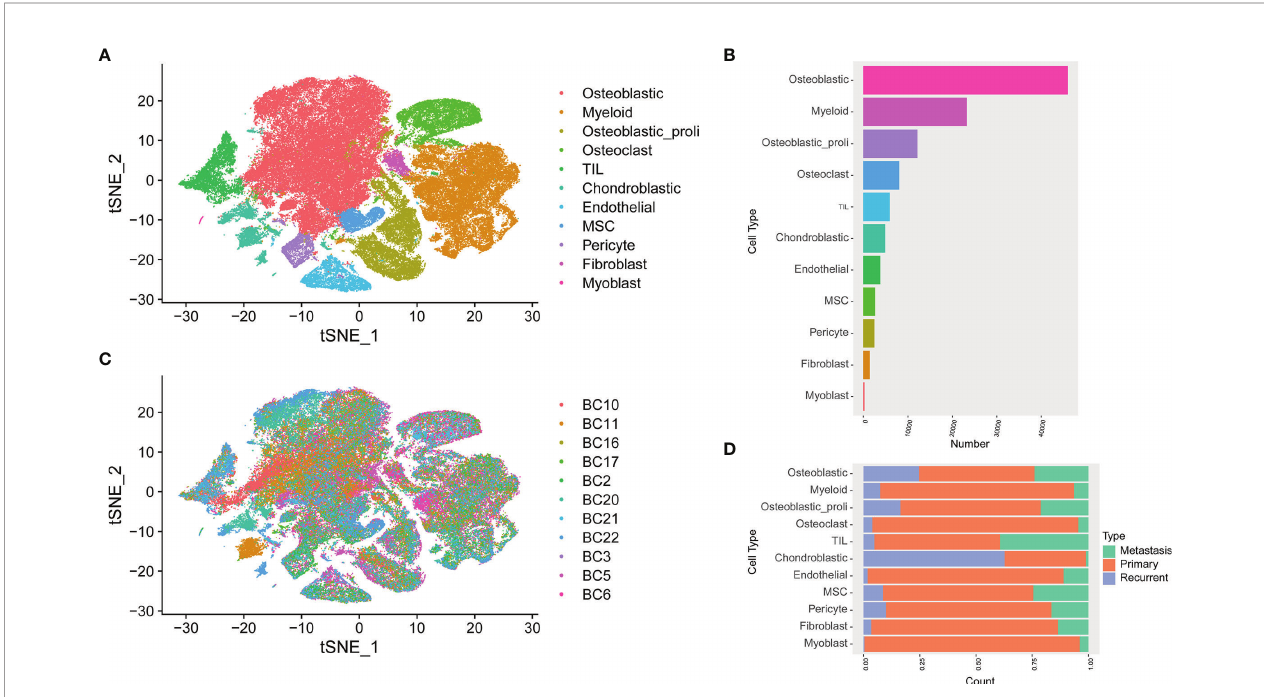
FIGURE 1 | Single-cell transcriptomic analysis of osteosarcoma tissues. (A) The t-SNE plot of different cell types in osteosarcoma tissues. (B) The relative proportion of each cell cluster in all osteosarcoma tissues was shown. (C) Similar t-SNE plot of different cell types colored according to the individual osteosarcoma sample. (D) The relative proportion of each cell cluster according to different types of osteosarcoma was